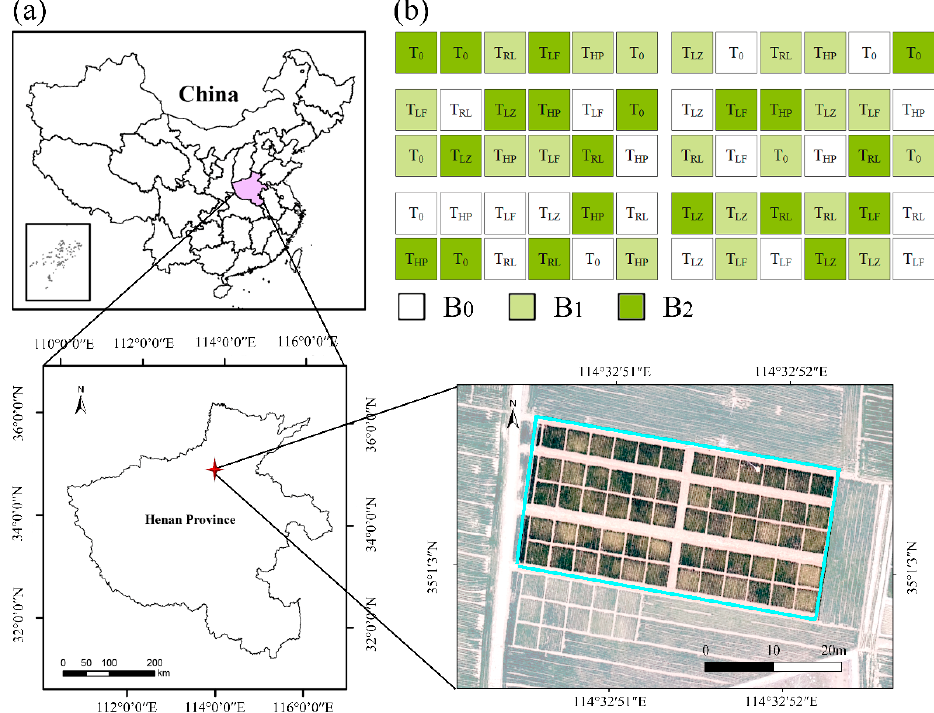
Figure 2. Study site and the experimental design. ( a ) The location of the Fengqiu Agro-ecological experimental station, CAS. ( b ) Experimental design (T HP , T LF , T RL , T LZ and T 0 are different topdressing methods, and basal fertilizer levels (B 0 , B 1 and B 2 ) are represented by different colors).